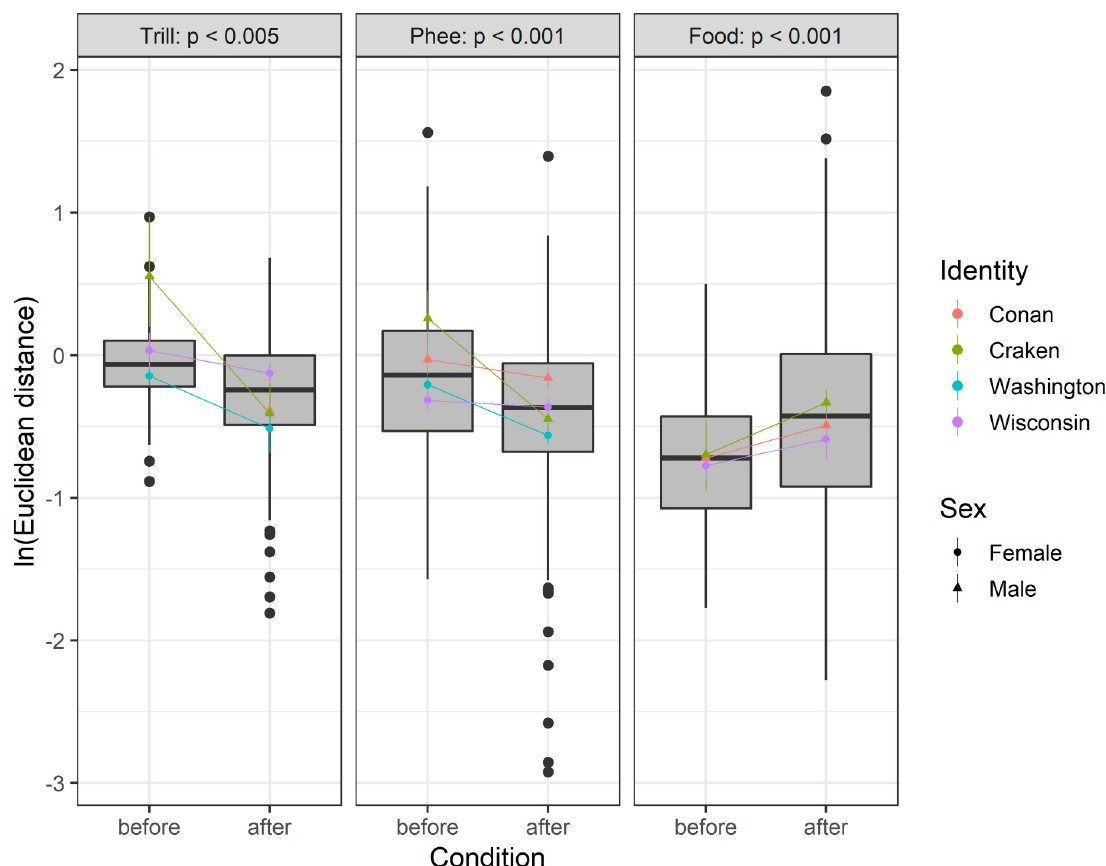
Fig 4. Social accommodation after 5+ weeks. The vocal distance was significantly larger immediately before translocation (last two weeks of the “ NewPhys ” condition = vocal distance 1 in Fig 2) than after 5+ weeks in the new colony (vocal distance 2 in Fig 2) for both phee- and trill calls. Food calls showed a slightly larger vocal distance after translocation, but effect size is small. Social accommodation thus persists over time and cannot be explained by short-term environmental